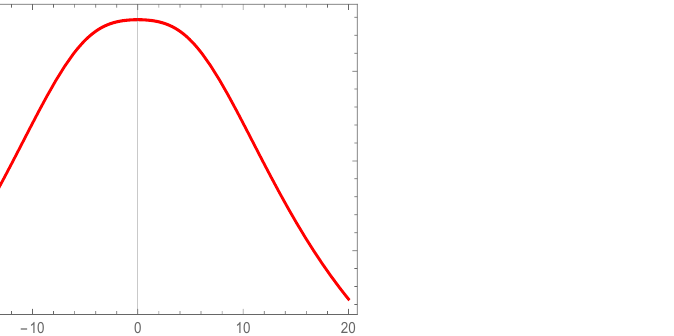
Figure 2. Variation of the effective potential with r for β = 9.5, M = 1, L = 1, and ξ = 4.1.